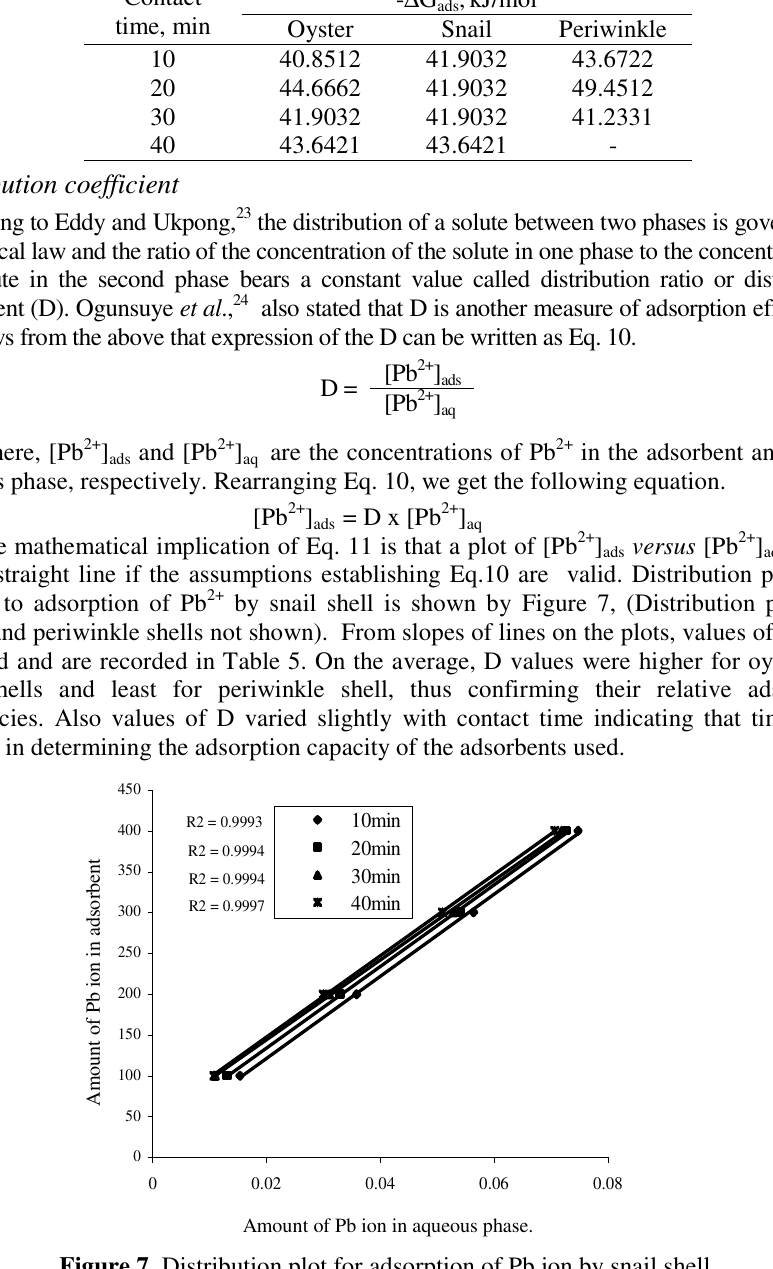
Figure 7 . Distribution plot for adsorption of Pb ion by snail